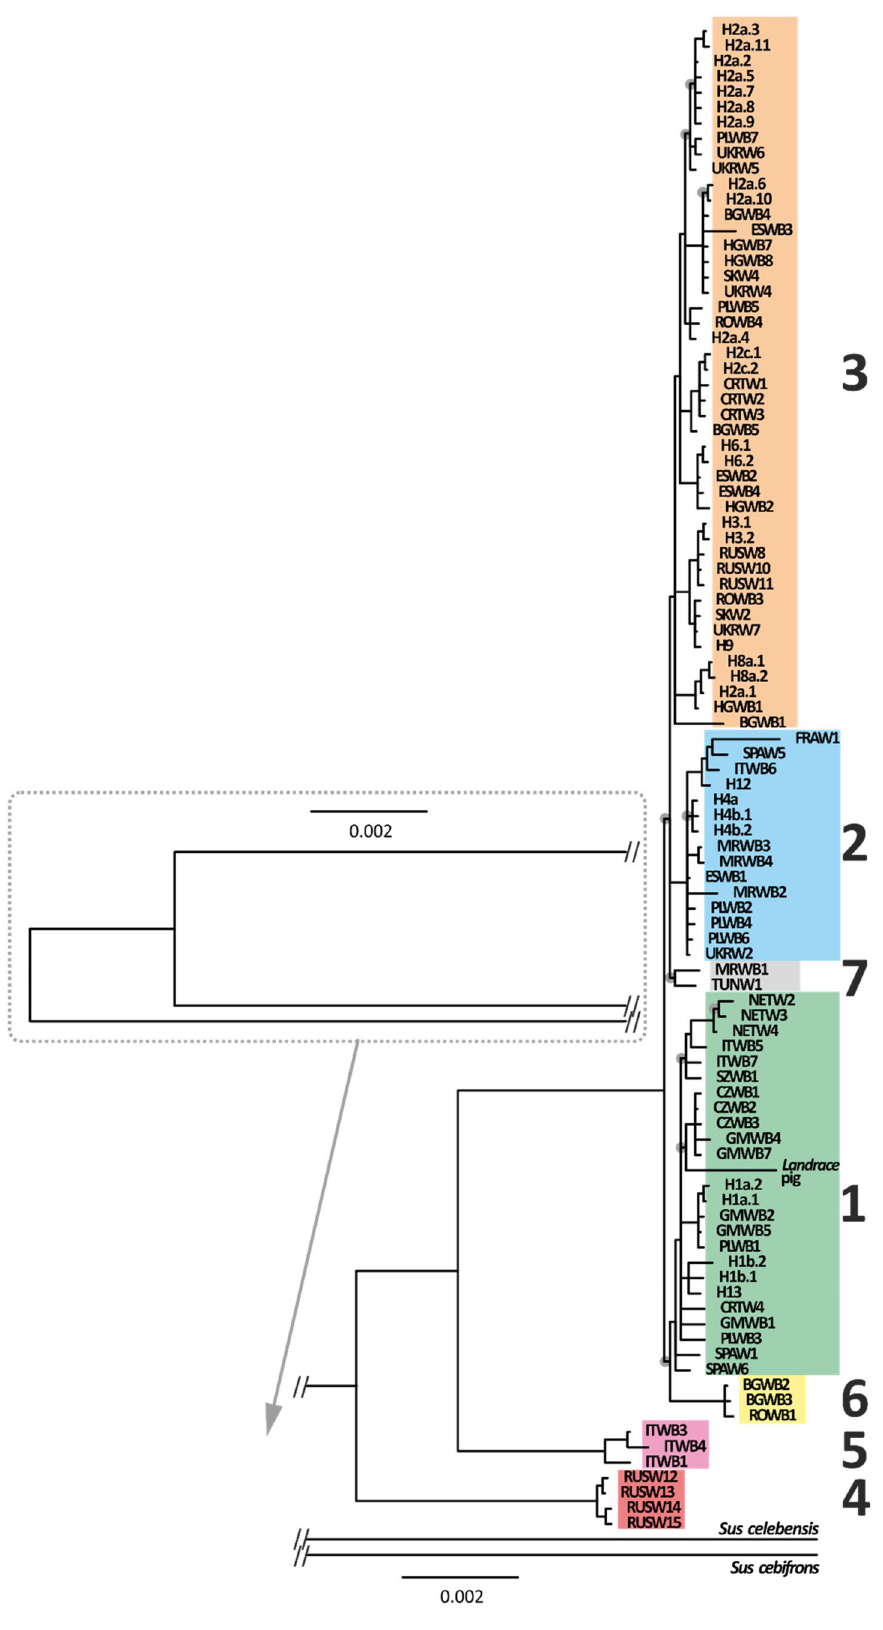
Figure 2. Bayesian phylogenetic tree (MCMC = 1 000,000) of mitogenome sequences of wild boar Sus scrofa . Posterior probability values on all branches were between 90 and 100. Black dots mark values in the range 63 –